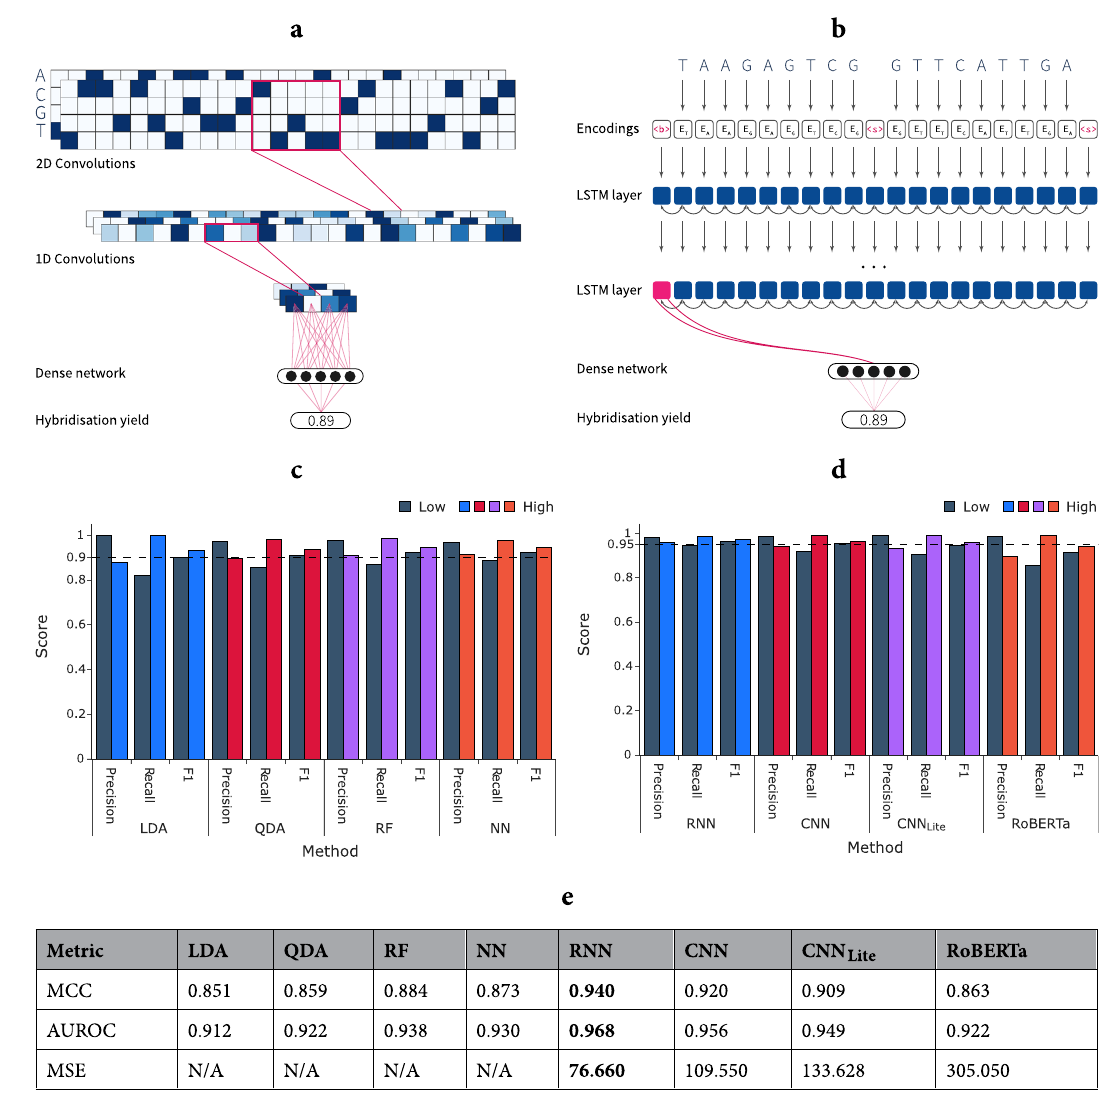
Figure 4. ( a , b ) Simplified representations of the deep learning architectures. ( a ) Convolutional Neural Network overview. Each of the columns in the 2-channel grid (image) corresponds to a one-hot encoding of the four nucleobases for that particular strand position, while each channel represents an entire strand. 2D convolutions on the 2-channel one-hot encoded DNA strands are followed by 1D convolutions (only 3 channels shown) and fully-connected layers. ( b ) Recurrent Neural Network overview. LSTM layers are widely used and recognised for their performance in language modelling tasks 23 , as well as other sequence-based tasks 24 . For readability, we represent bi-directional interactions with two-headed arrows between the sequence elements. ( c – e ) Classification and regression results for the evaluated machine learning models. The choice of metrics is explained in the “Methods” section. ( c , d ) Graphical summary of precision, recall and F 1 score for the two classes of machine learning models. The Low class is represented by dark grey and the High class corresponds to the four bright colours (one colour for each method eases readability). ( c ) The four baseline ML algorithms. Exact numerical values are provided in Supplementary Table 1. ( d ) Classification metrics for the four deep learning models, after yield binarisation (with a threshold of 0.2). The numerical values are provided in Supplementary Table 2. ( e ) The AUROC and MCC summarise the classification performance of all evaluated machine learning techniques; additionally, the MSE (Mean Squared Error) is reported for the four deep learning